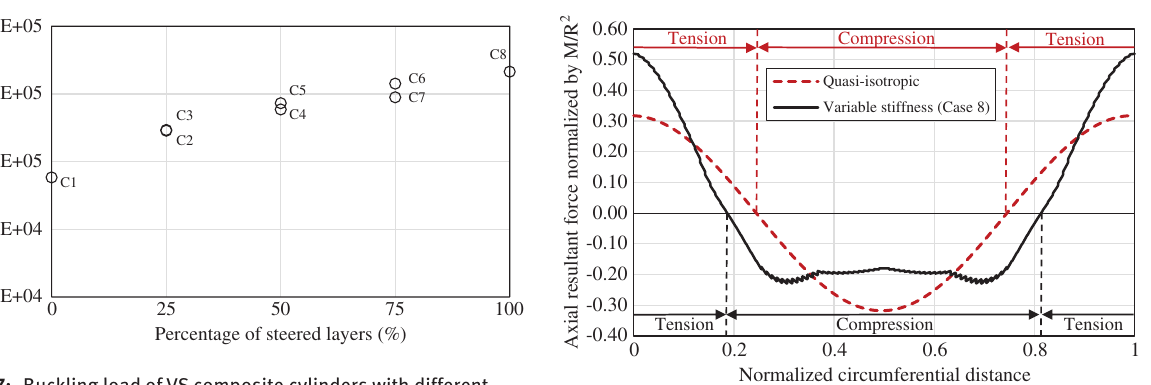
Figure 7: Buckling load of VS composite cylinders with different stacking sequence cases listed in Table 2.